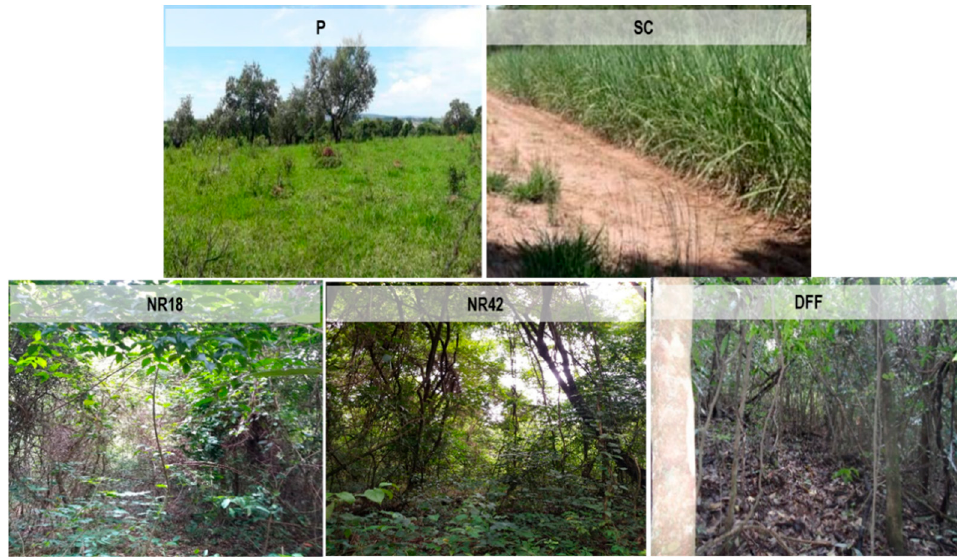
Figure 2. Image of the study areas. P: Pasture; SC: Sugarcane; NR18: Passive restoration by natural regeneration 18 years; NR42: Passive restoration by natural regeneration 42 years; DFF: Degraded forest fragment. Table 1. Soil classification, soil particle density ( ρ s ), particle size distribution, and textural classes for the soil superficial horizon (0.10 m) of the study areas.